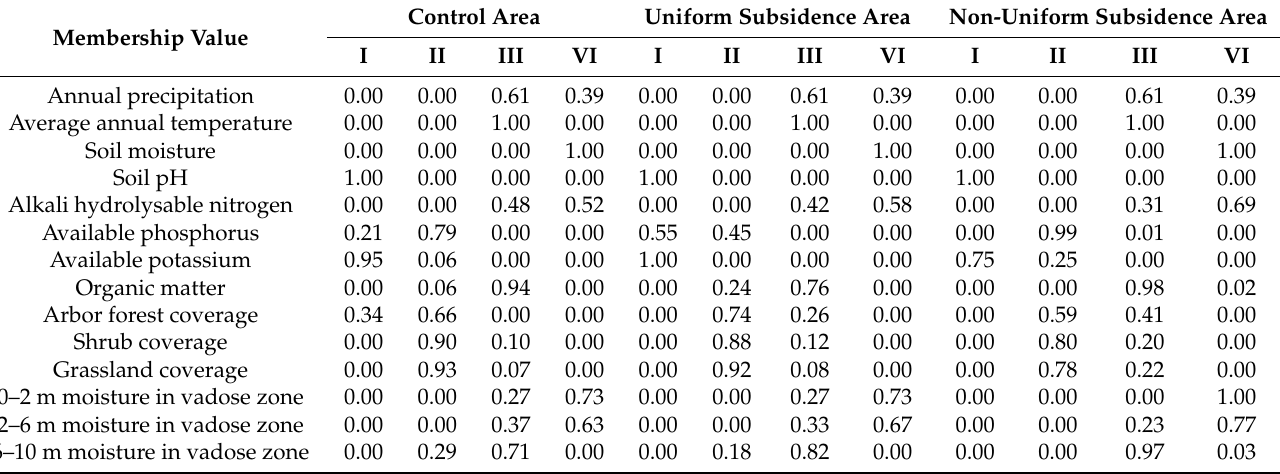
Table 4. The membership value of the ecological evaluation index in the index